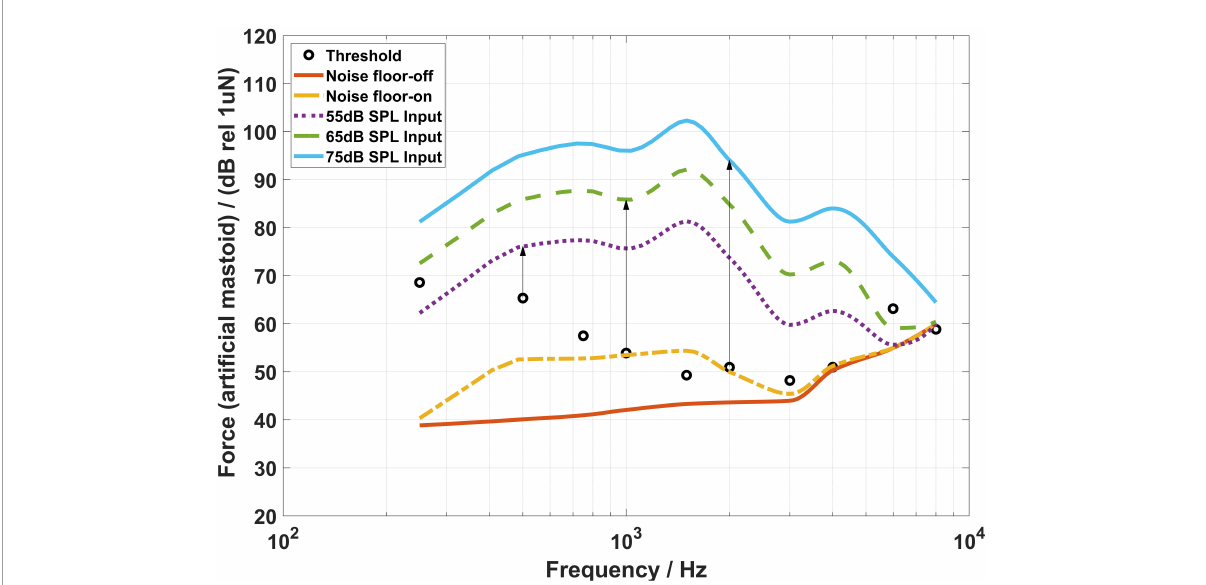
FIGURE6 The FL_AM corresponding to the bone conduction (BC) hearing threshold (referenced to the artificial mastoid) and the aided responses at 55, 65, and 75 dB SPL input levels. The arrows depict the audibility calculations.